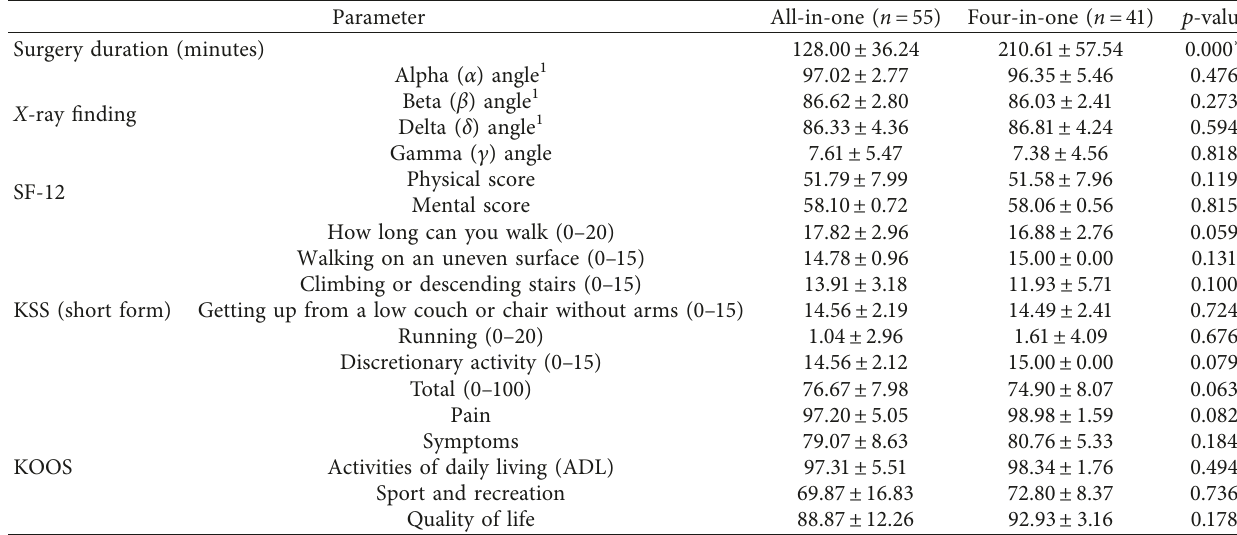
Table 3: Outcome comparison between all-in-one & four-in-one